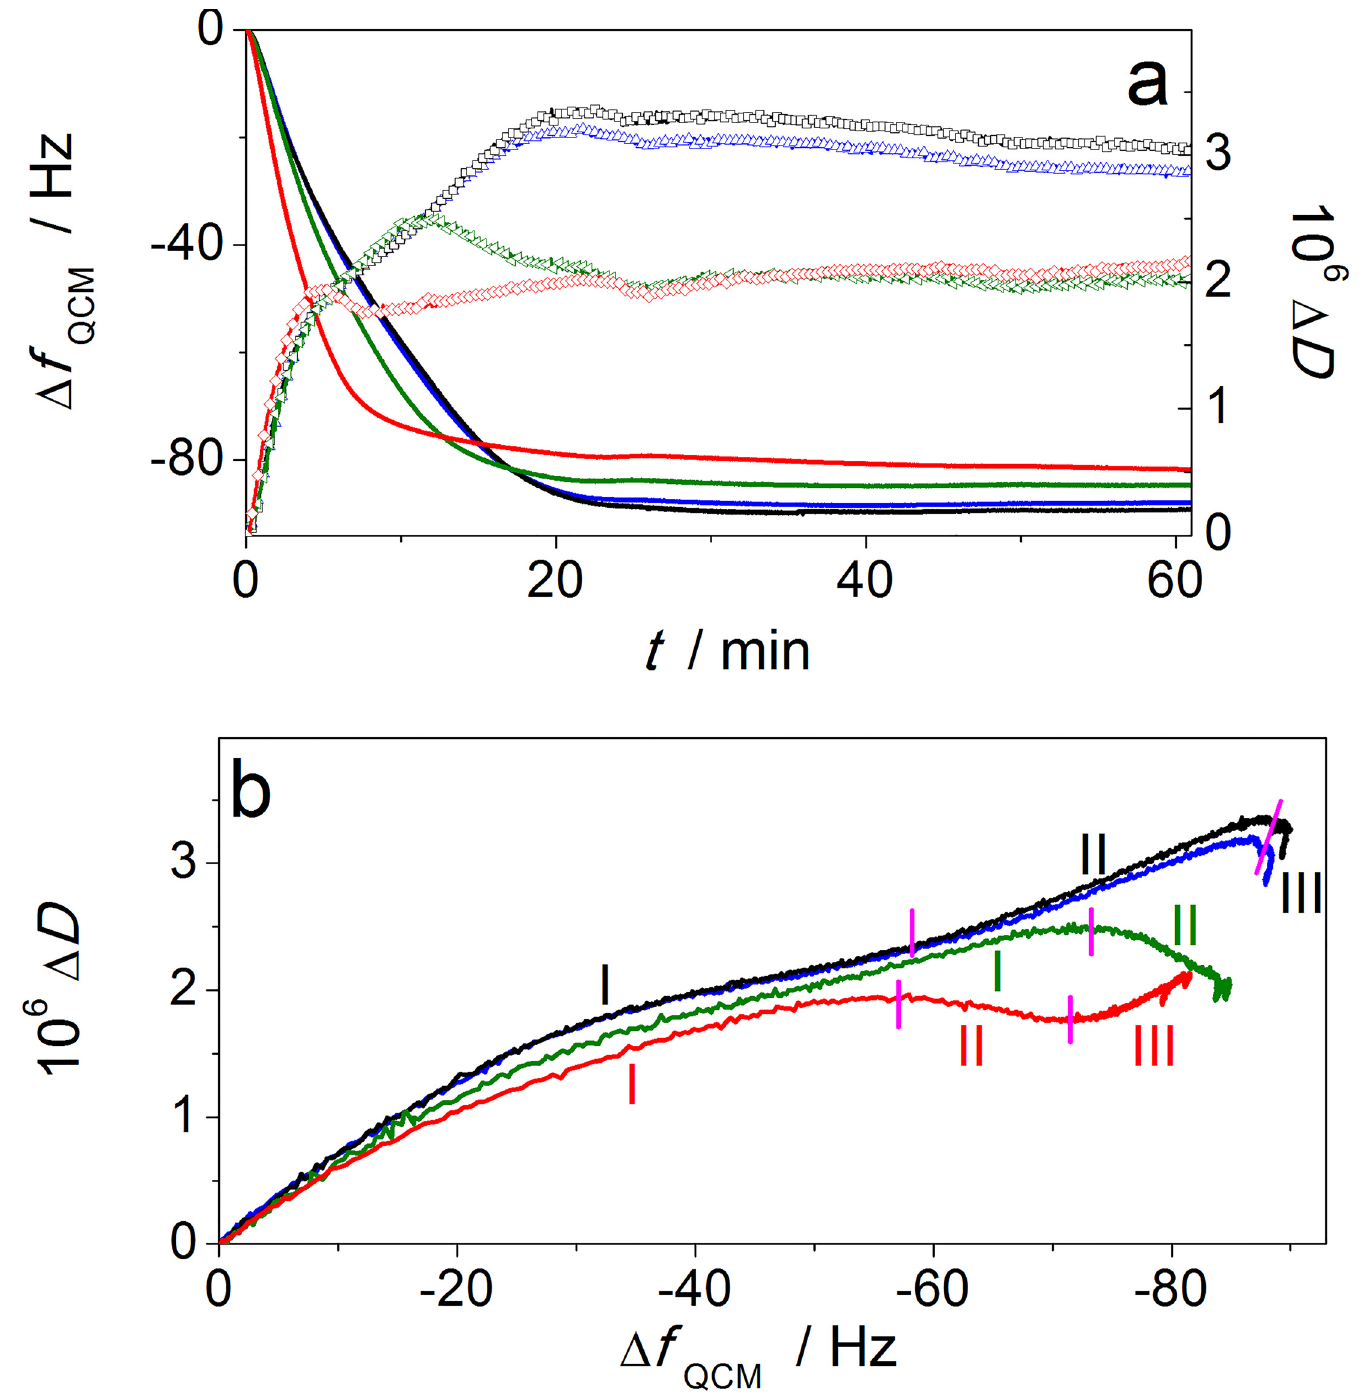
Fig 2. Quartz Crystal Microbalance data for proteins binding to a membrane layer. a, QCM data showing changes in frequency (lines, left axes) and dissipation (symbols, right axes) (7 th harmonic; Δ f QCM data are normalized to the overtone number) derived from deposition of proteins onto a DMPC- cholesterol membrane pre-deposited on a mpa-layer adhered to a Au-coated quartz crystal. QCM profiles obtained with protein mixtures 20 nM P450c17+20 nM CPR+20 nM wt cyt b5 (blue) and 20 nM P450c17 + 20 nM CPR + 100 nM wt cyt b5 (black) were similar to each other and also to that for 20 nM P450c17 +20 nM CPR (Figure H in S1 File). In contrast, the E48G/E49G cyt b5 was deposited non-specifically and competitively with P450c17+CPR, as determined with 20 nM P450c17+20 nM CPR+20 nM E48G/E49G cyt b5 (green) and especially 20 nM P450c17+20 nM CPR+100 nM E48G/E49G cyt b5 (red) mixtures. b, Analysis of the QCM data using Δ f QCM vs . Δ D ‘ fingerprint ’ plots of the temporally resolved data from panel (a). The traces were divided into characteristic deposition stages labeled with roman numerals (I – III). DMPC = 1,2-dimyristoyl- sn -glycero-3-phosphocholine; mpa = mercaptopropionic acid.